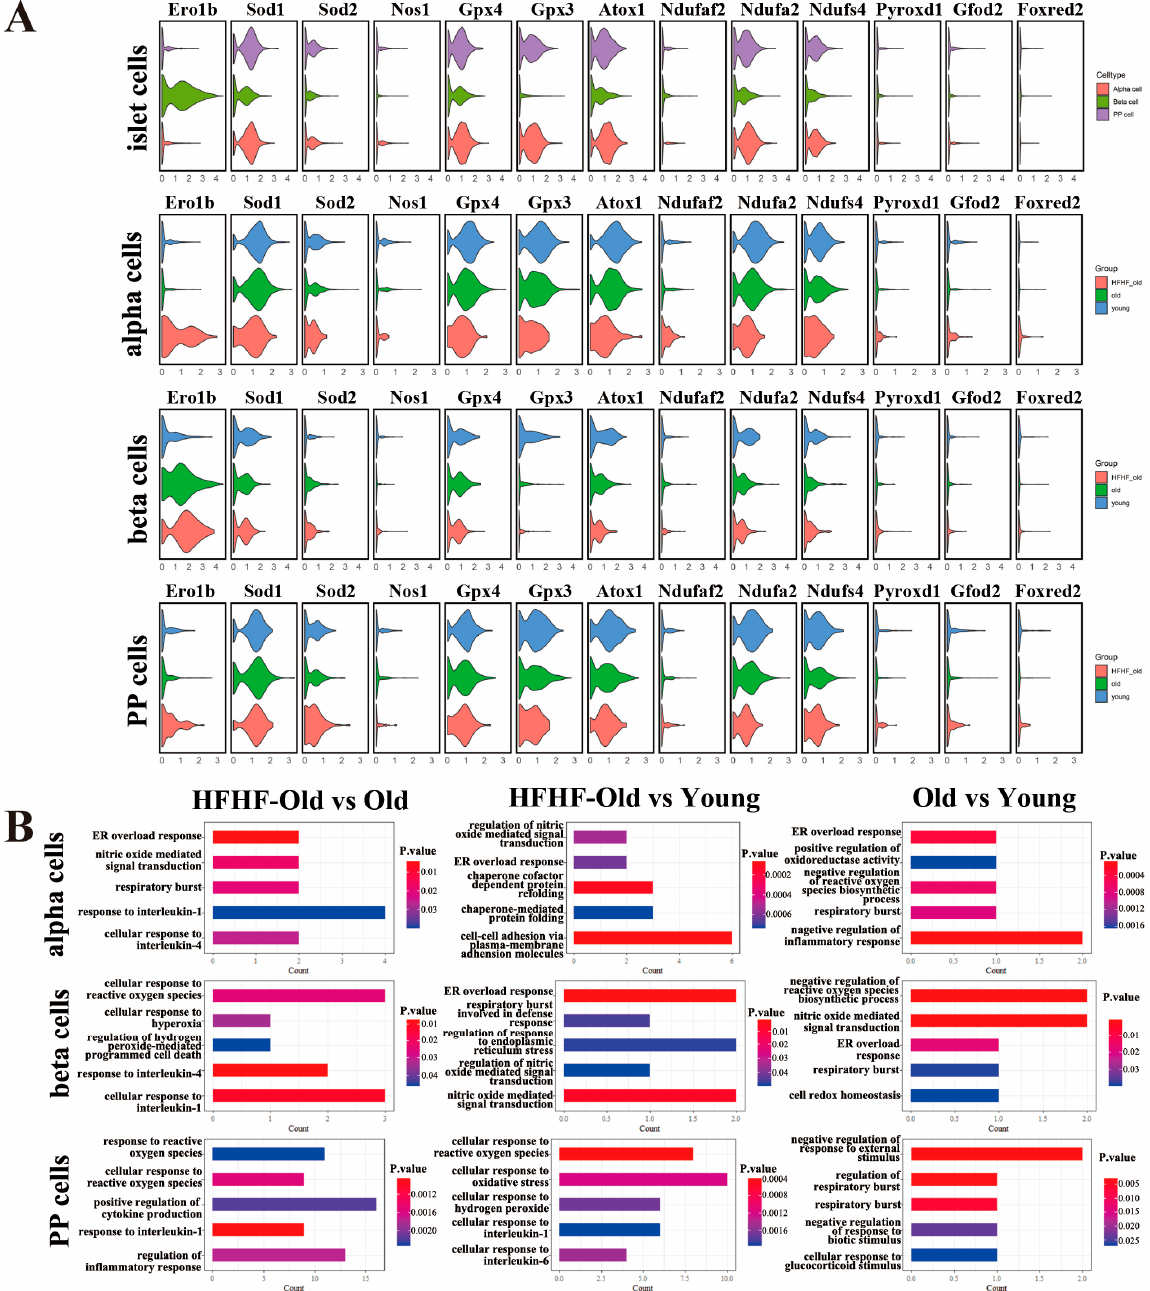
Figure 7. Distinct expression of oxidative-related oxidoreductase genes and Gene Ontology (GO) anal- ysis findings among three groups. ( A ) Violin diagram characterizing the expression of oxidoreductase genes in islet alpha, beta, and PP cells at the beginning (young) and after 18 months (HFHF-old, old) of diet feeding. ( B ) GO terms of upregulated OS and inflammation-related enrichment obtained in islet alpha, beta, and PP cells after a pairwise comparison of three groups ( p <